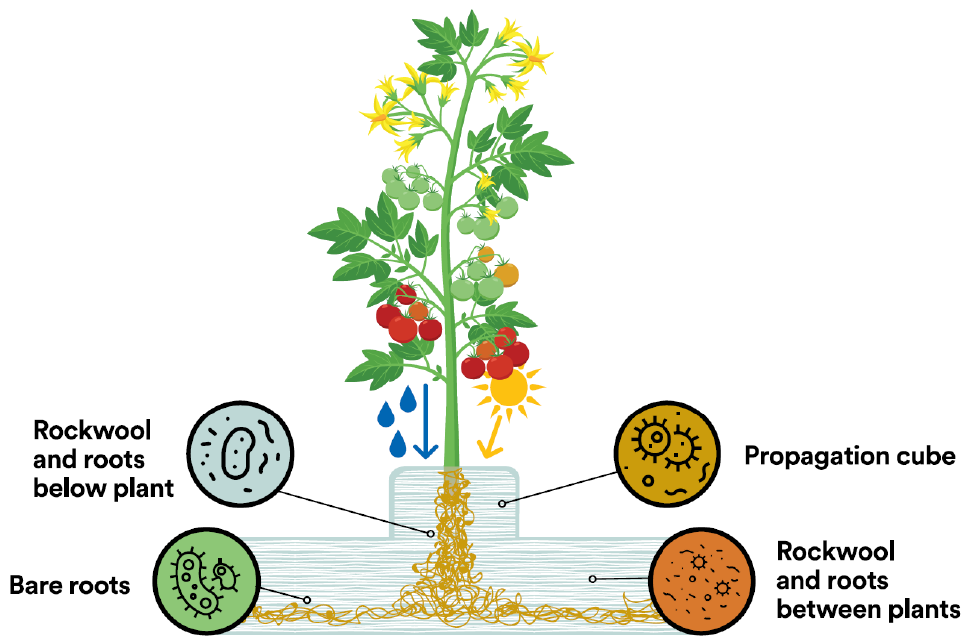
Figure 4. Assembly of distinct microbial communities at different locations in the root zone due to consistent variation in important environmental characteristics (e.g., pH, EC, sunlight, irrigation, root